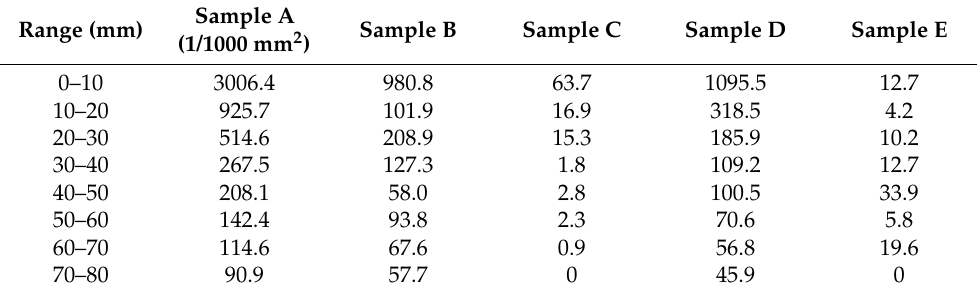
Table 3. The density for radial distribution of OISFs after a high-temperature wet oxidation and the MAE2 etching.